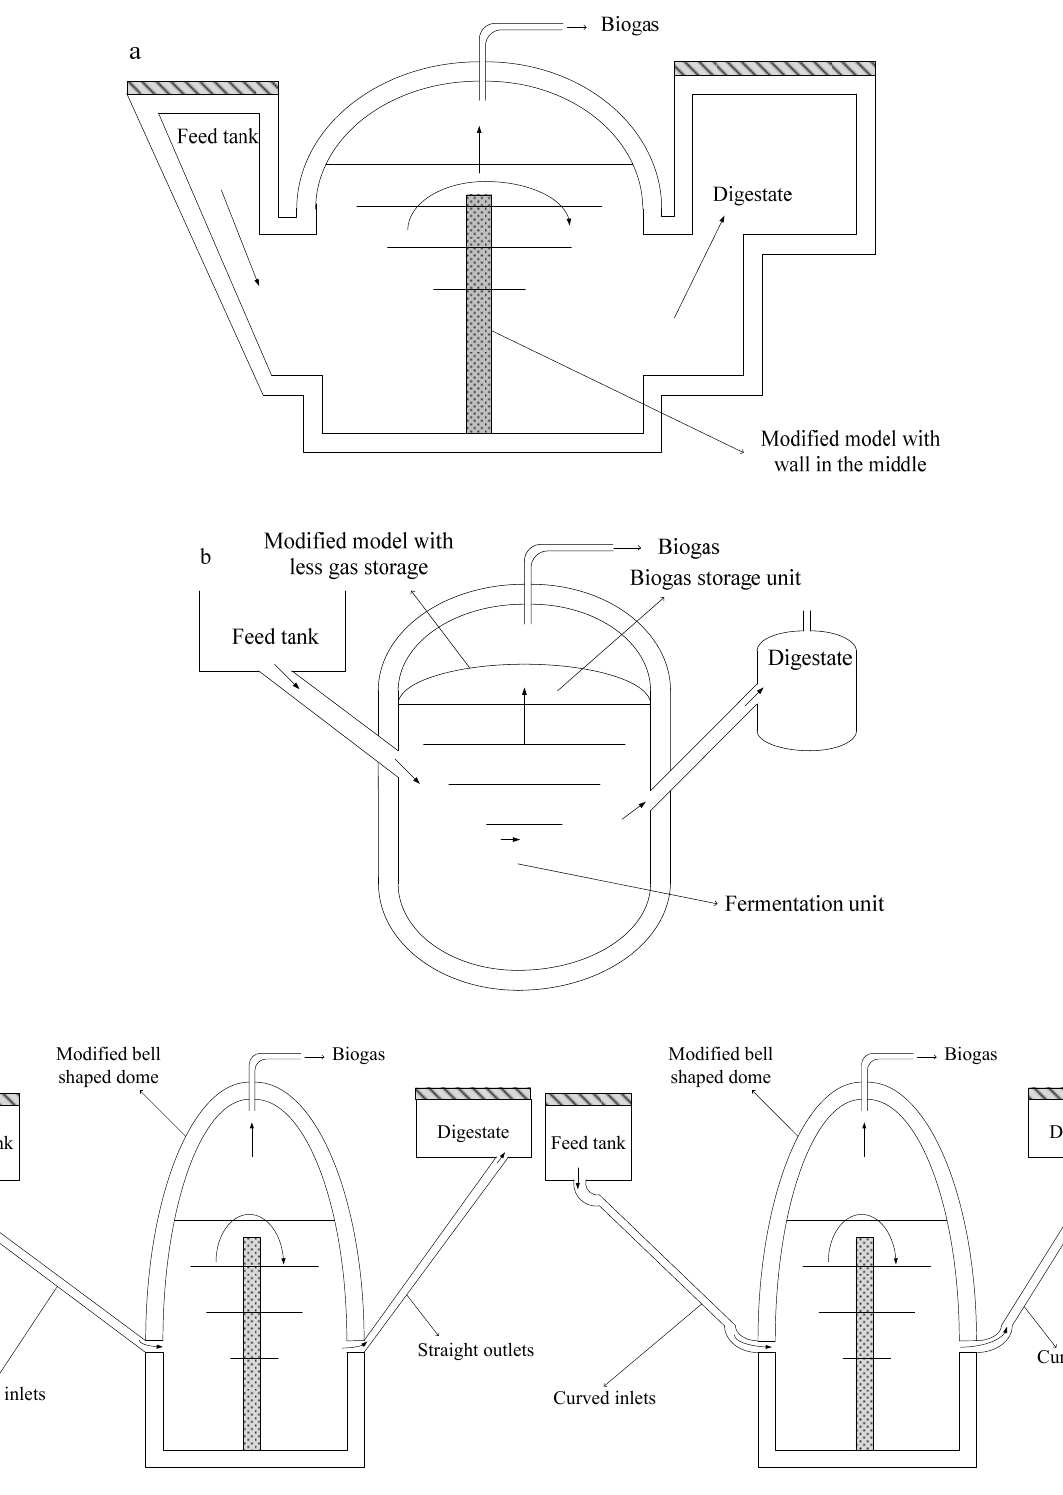
Figure 1. Schematic sketch of ( a ) a janta model fixed dome digester and its modifications, ( b ) a deenbandhu model fixed dome digester and its modifications, and ( c ) a modified fixed dome digester with straight and curved inlet and outlet